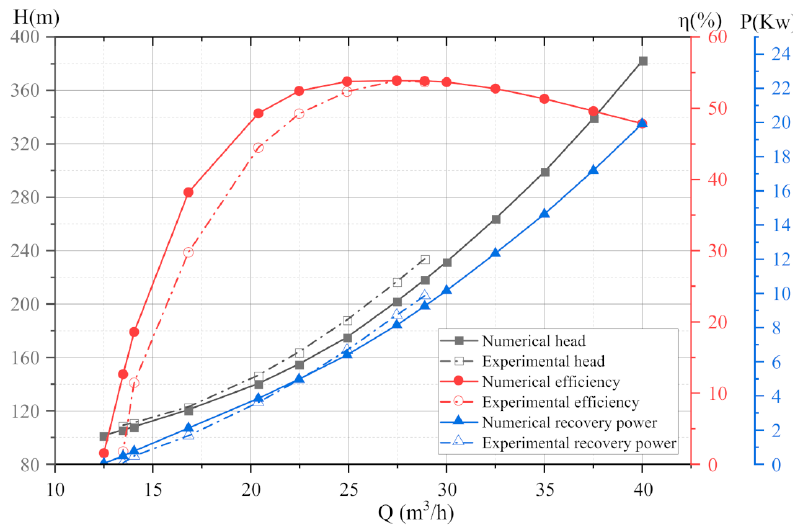
Figure 5. Comparison of numerical simulation and test